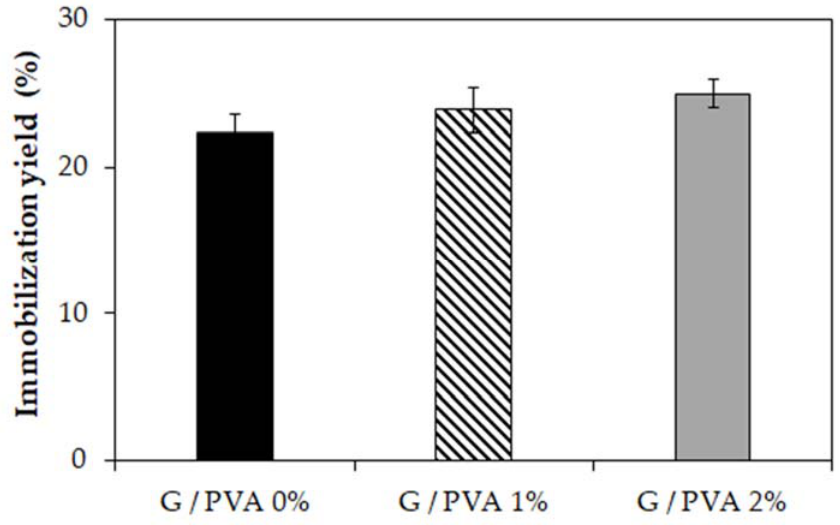
Figure 5. The yield of immobilization of invertase from Saccharomyces cerevisiae using different hydrogel matrices as the carrier. Gelatin-based hydrogel without PVA (G/PVA 0%, black), a gelatin- based hydrogel with 1% w / v of PVA (G/PVA 1%, striped), and gelatin-based hydrogel with 2% w / v of PVA (G/PVA 2%, grey). Mean value of three independent repetitions.